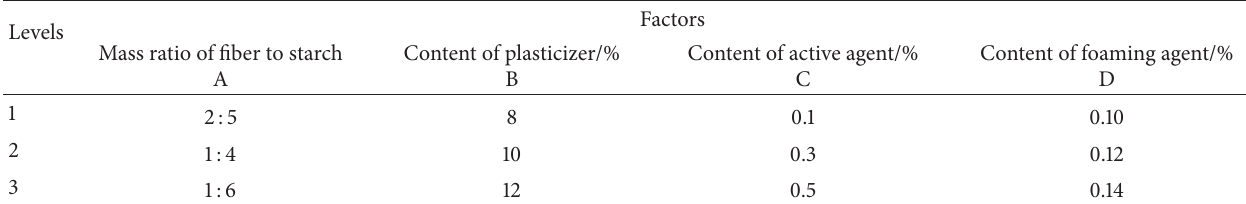
Table 1: Experiment factors and